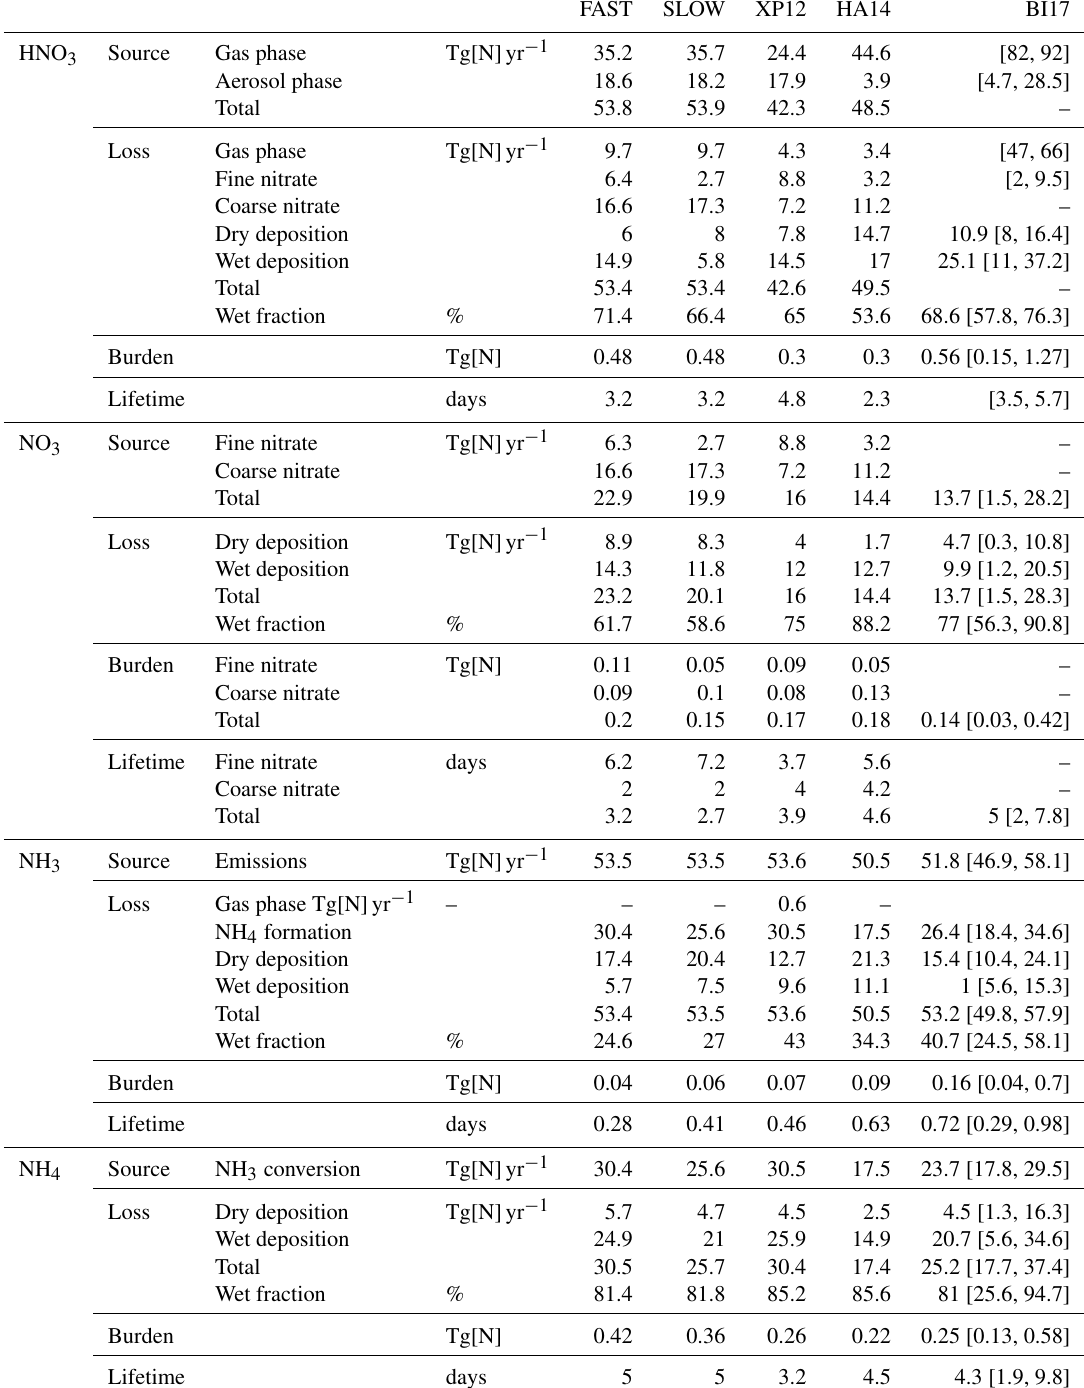
Table 3. Global and annual-mean metrics for nitric acid (HNO 3 ), nitrate (NO 3 ), ammonia (NH 3 ) and ammonium (NH 4 ) in the FAST and SLOW simulations compared to Xu and Penner (2012) (XP12), Hauglustaine et al. (2014) (HA14), and the AeroCom phase III model intercomparison project described in Bian et al. (2017) (BI17). Square brackets in the BI17 column denoted the AeroCom inter-model